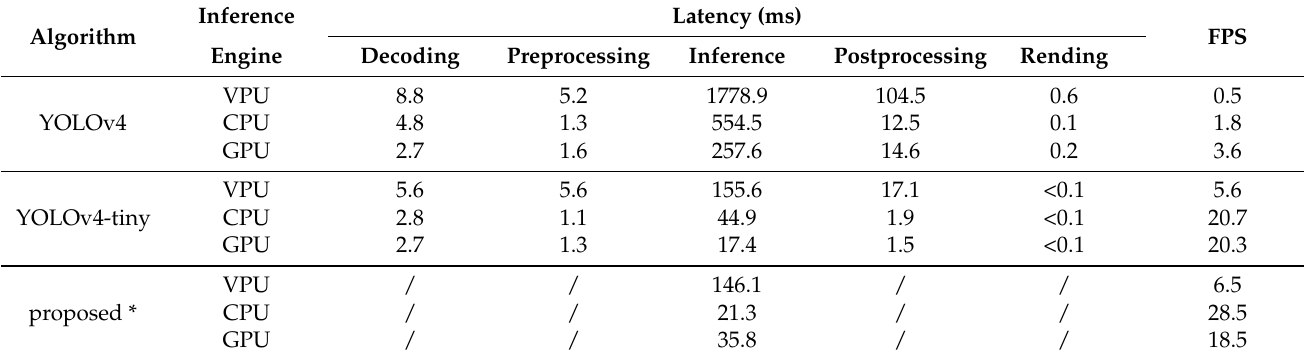
Table 5. The results of inference test based on OpenVINO.